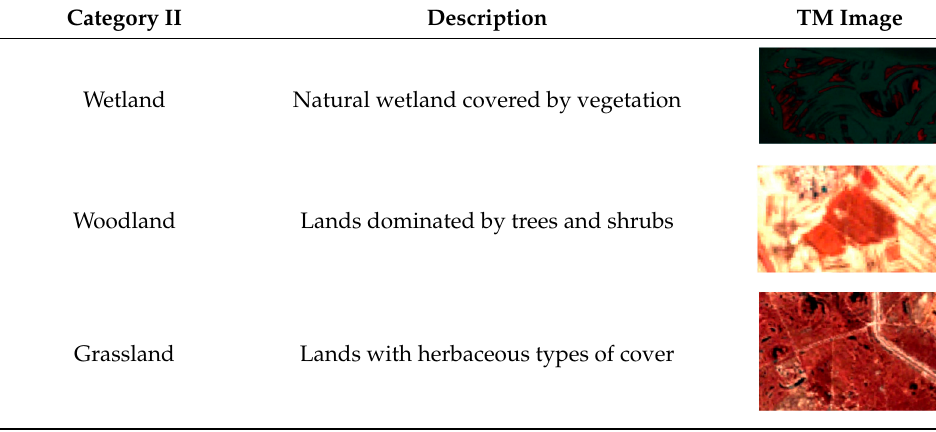
Table 1. Land cover classification system for the CARB.